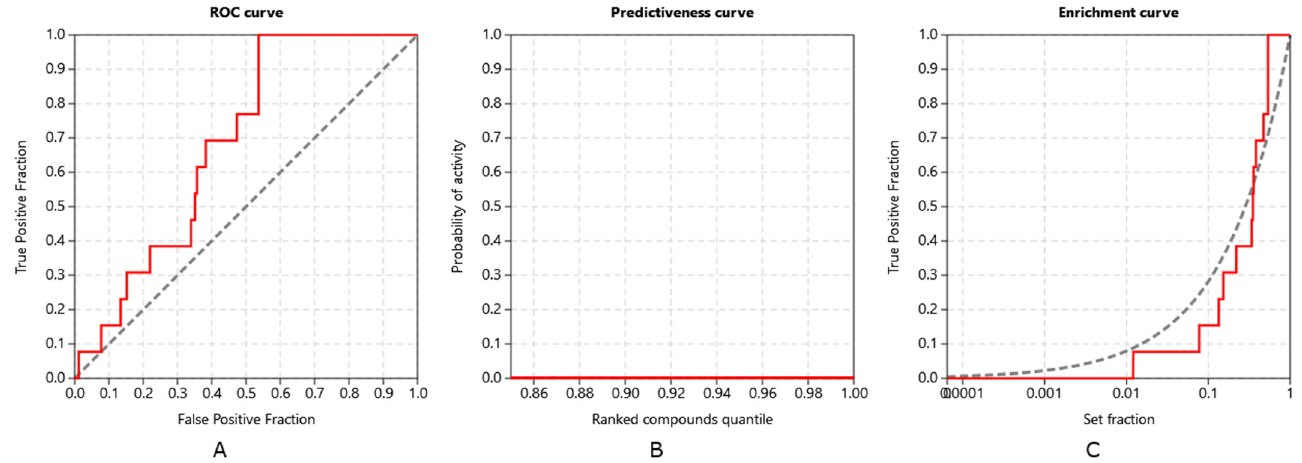
Figure 7. Validation of the inverse molecular docking protocol of xanthohumol against all human protein targets from the Protein Date Bank (PDB): ( A ) the receiver operating characteristics (ROC) curve; ( B ) the predictiveness curve; and ( C ) the enrichment curve.